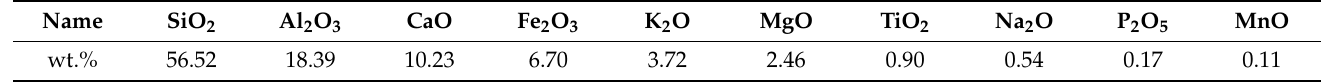
Figure 5. Outdoor temperature and relative humidity in Mianyang. Table 3. Chemical composition of rammed